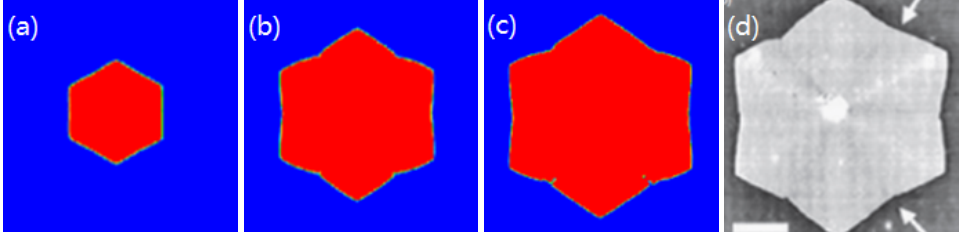
Figure 1. When K 0 = 0.95 , the morphology of dendrites is obtained by numerical simulation. (( a – c ) are the numerical simulation results with time iteration steps of 1000, 2000, and 3000, respec- tively. ( d ) is the experimental result).